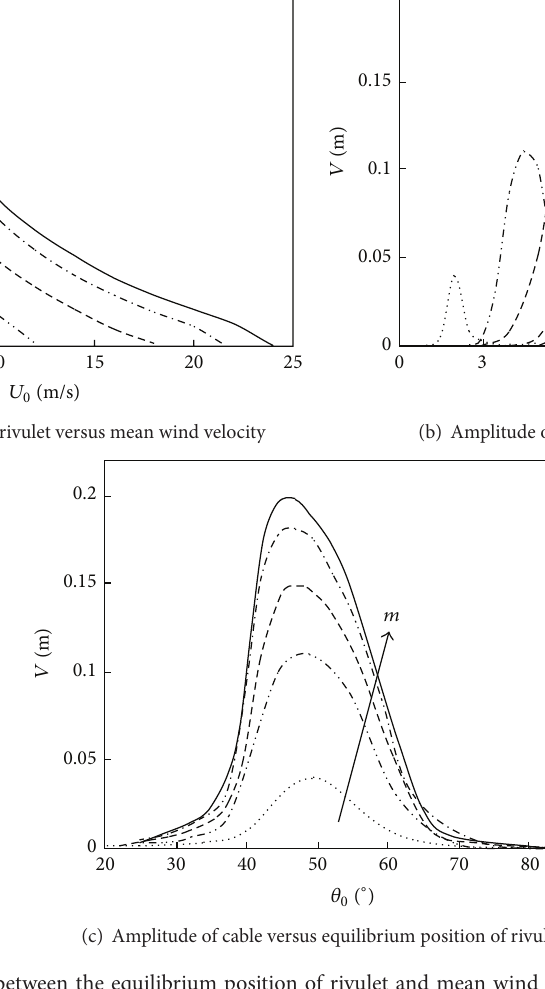
Figure 5: The correspondences between the equilibrium position of rivulet and mean wind velocity with a certain rivulet mass. Arrows indicate the growing direction of 𝑚 ( 𝑚 = 0.01 , 0.05, 0.1, 0.16,